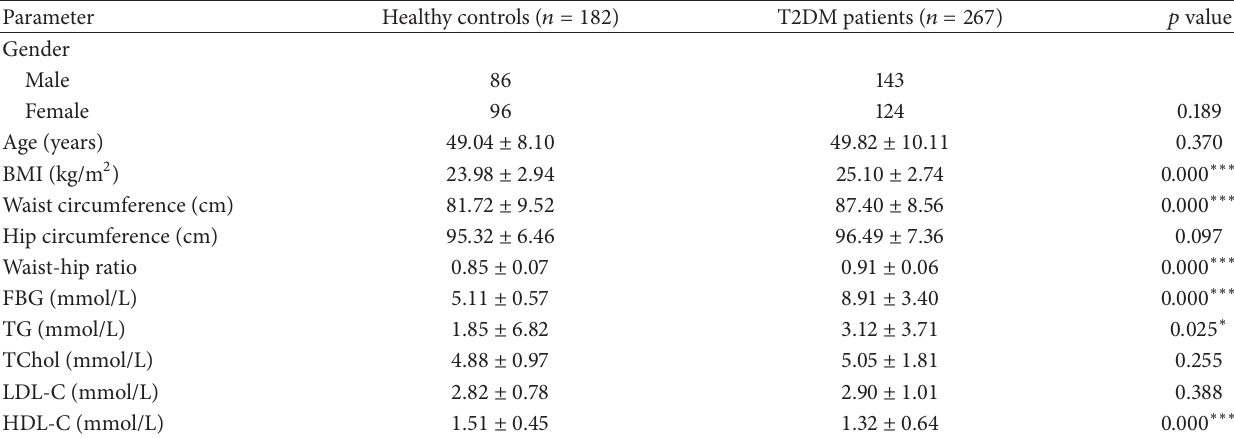
Table 1: The clinical characteristics of T2DM patients and healthy subjects.